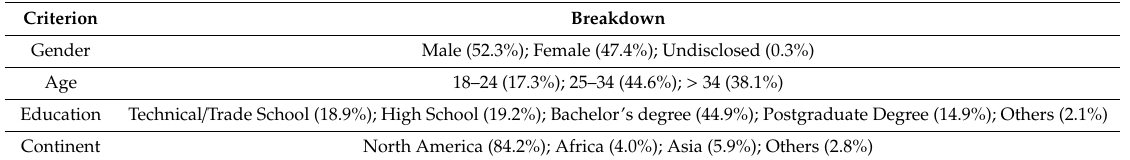
Table 3. Demographics of participants (n =